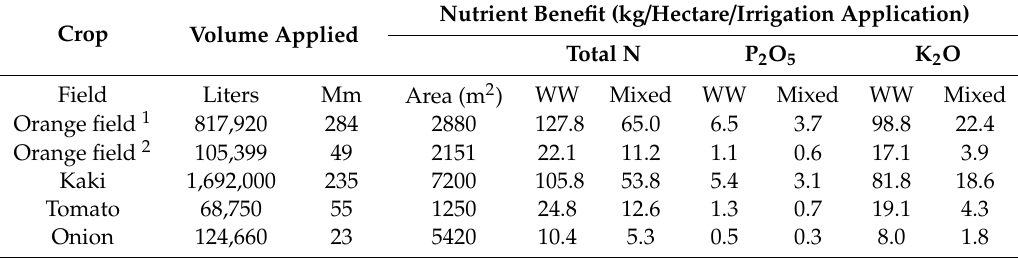
Table 4. Calculated benefit of total nitrogen (N), phosphorous oxide (P 2 O 5 ) and potassium oxide (K 2 O) in the treated waste-water (WW) and surface water mixed with treated waste-water (Mixed).